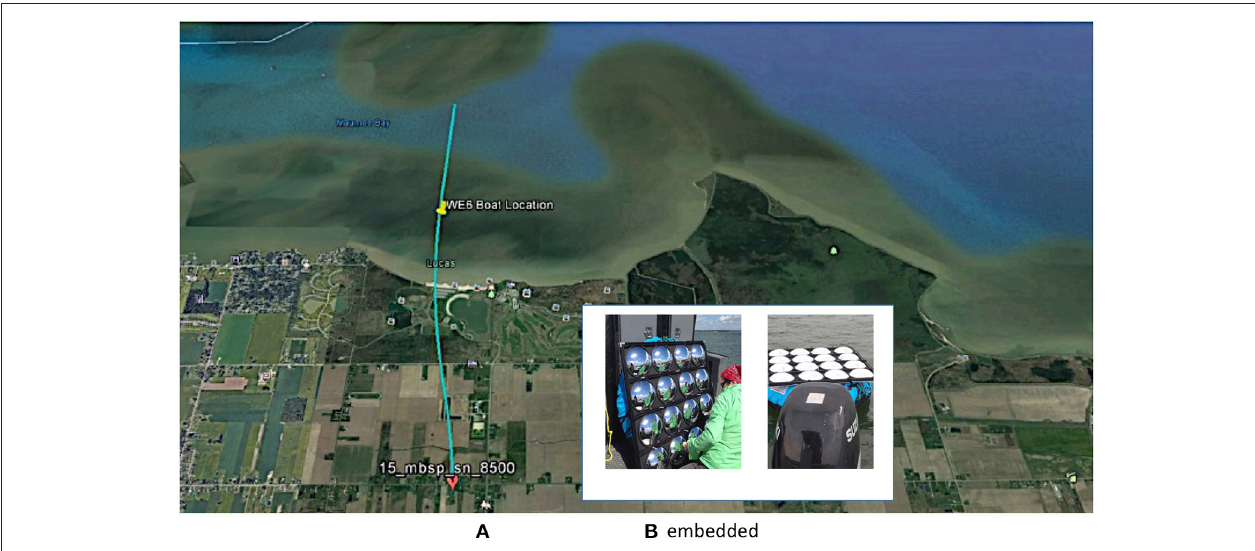
FIGURE 1 | (A) Maumee Bay State Park is the location where the NASA Glenn, second generation Hyperspectral imager (HSI2) swath 15_MBSP was collected on June 21, 2016. Sampling station Western Erie 6 (WE6) is indicated, where measurements were taken from the boat, and the mirror array was deployed. (B) Inset: mirror calibration panel being cleaned on deck and deployed behind the vessel in Sandusky Bay (After Figure 4.3 with modification, Lekki et al.,